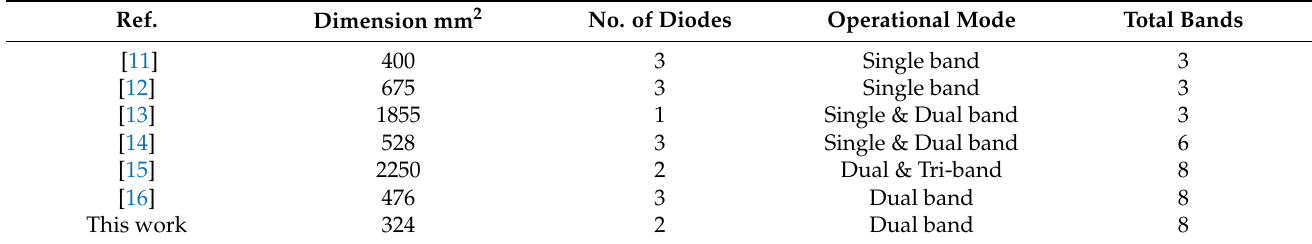
Table 1. Performance comparison with existing